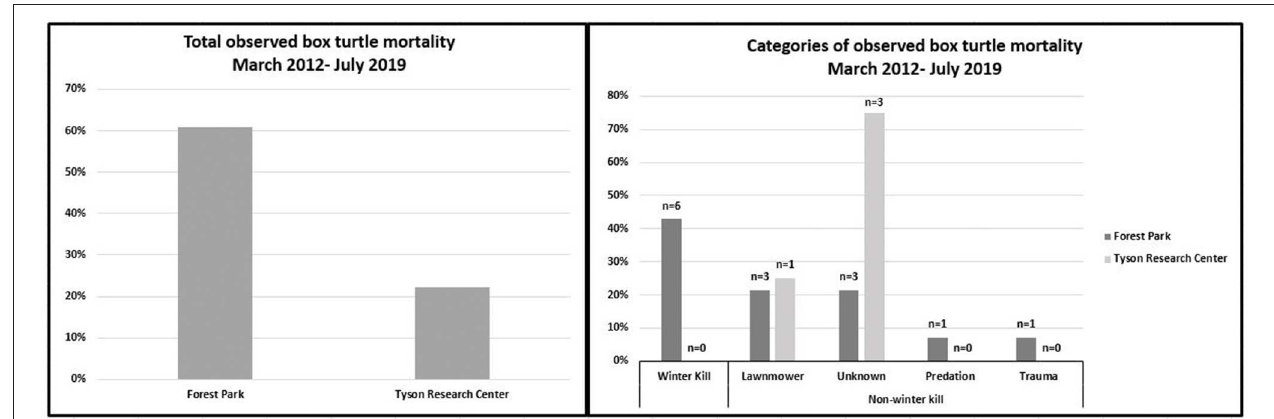
FIGURE 2 | Total observed mortality in box turtles at Tyson Research Center and Forest Park. Categories of observed mortality in the mortality study of box turtles in Missouri.